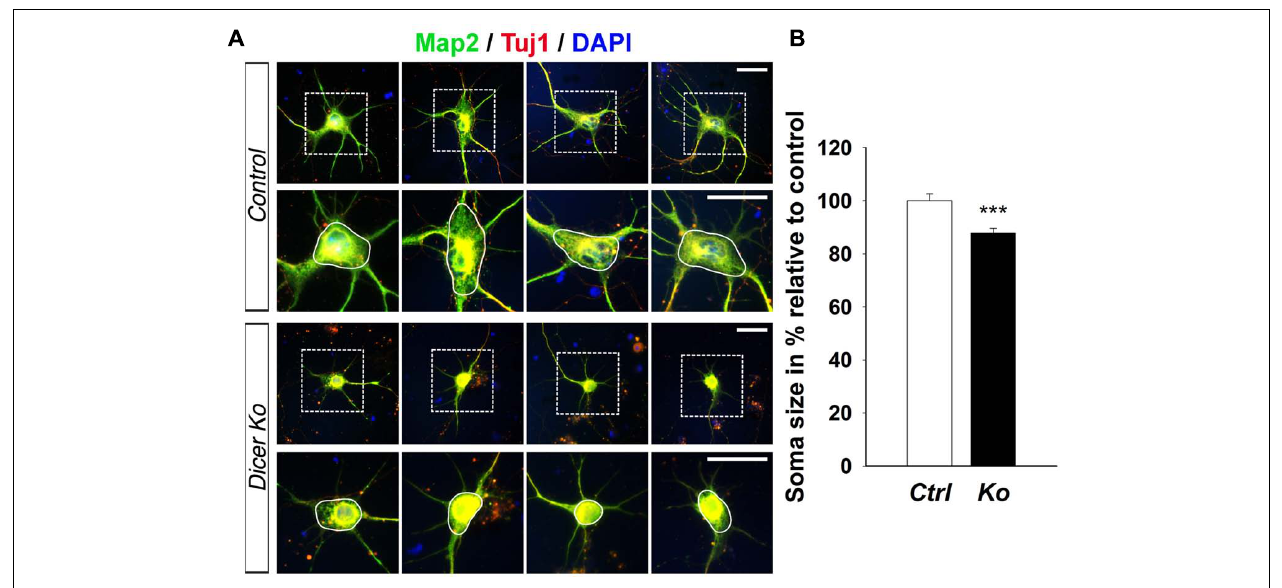
FIGURE 6 | miRNA depletion in maturing cortical neurons causes a reduction of soma size in vitro . (A) Immunofluorescence microscopy of control ( Ctrl ) and Nex-Cre-Dicer Ko ( Ko ) primary neural cultures at 10 days in vitro (DIV 10) showing Map2 (green),Tuj1 (red), and DAPI (Jentarra etal., 2010).The dashed box indicates the region shown at higher magnification.